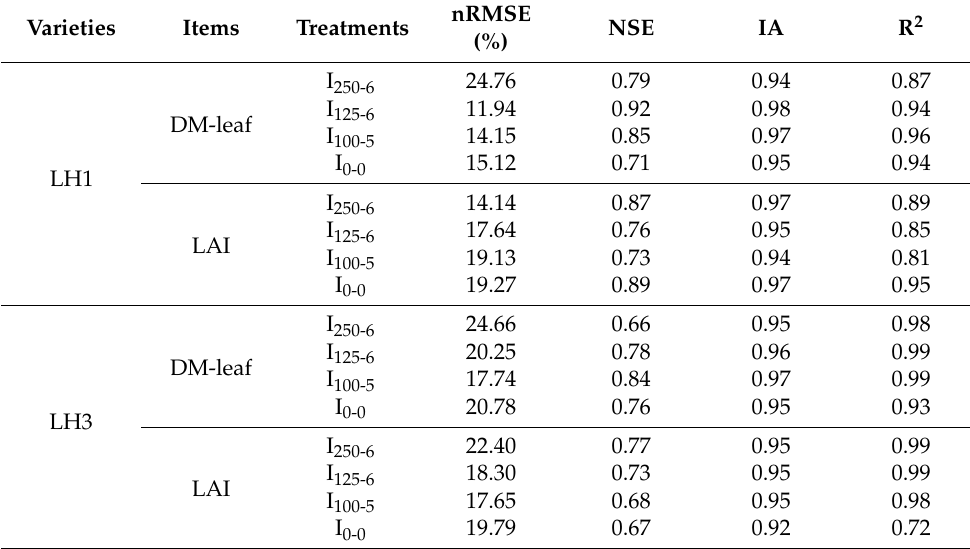
Table 4. Statistical criteria for simulation of LAI and DM-leaf (the dry matter weight of leaf) consider- ing sampling error caused by